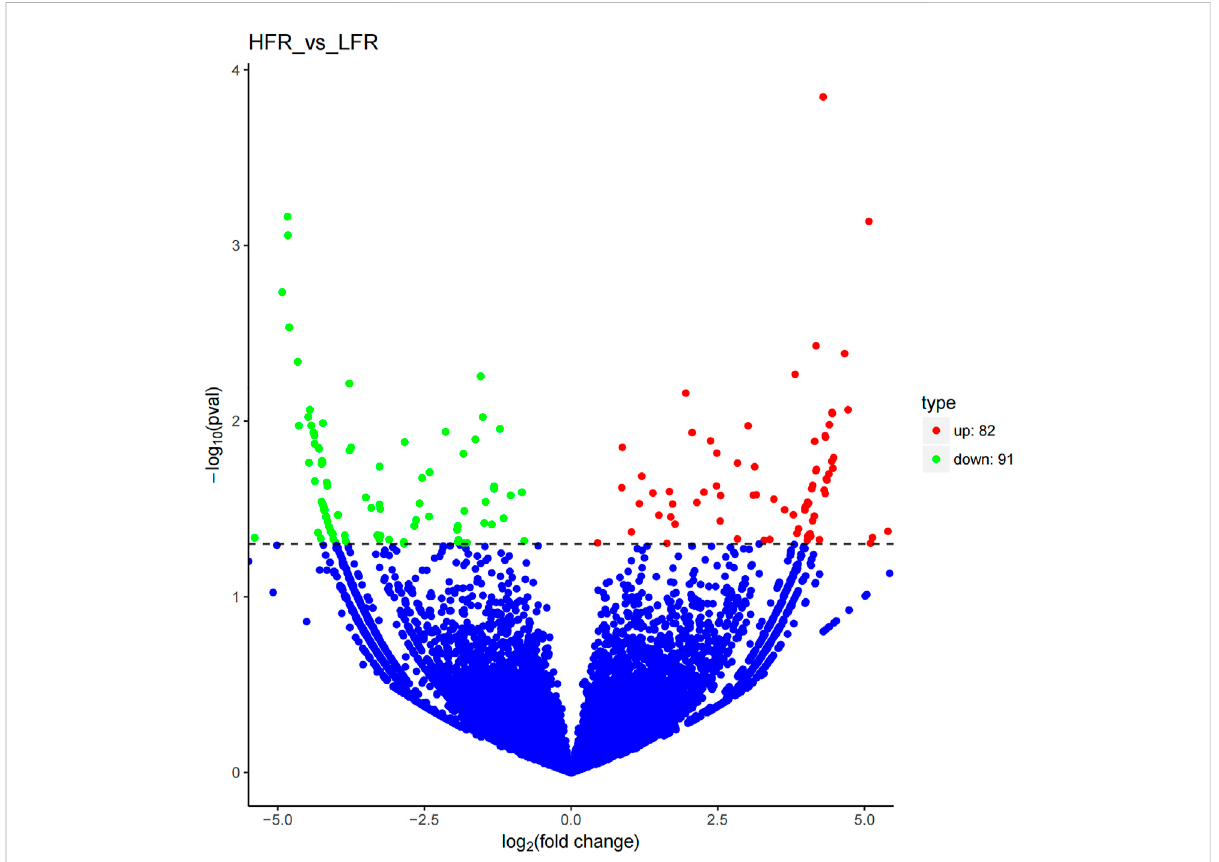
FIGURE 5 Differential circRNA volcano map. Differentially expressed circRNAs were fi ltered using a p < 0.05 as a threshold. Red spots represent up- regulated circRNAs, andgreenspotsindicate down-regulated circRNAs. Bluespots represent circRNAsthat didnot show obviouschanges between the HFR and LFR